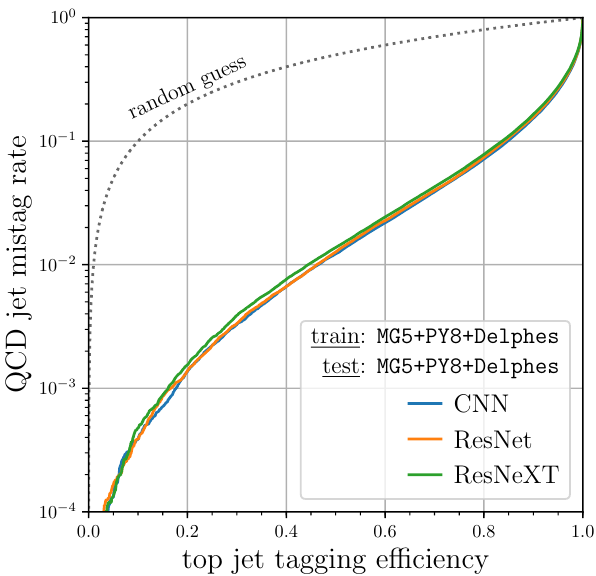
Figure 16. The ROC curves of the CNN and its variants: ResNet and